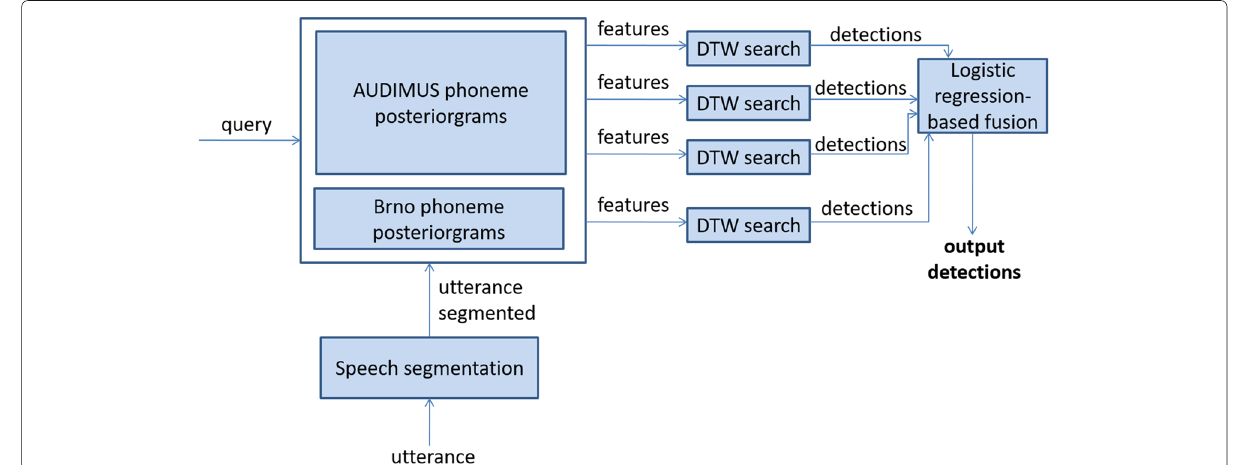
Fig. 2 B-L2F-Four phone log-likelihood ratio feature+DTW-based fusion QbE STD system architecture